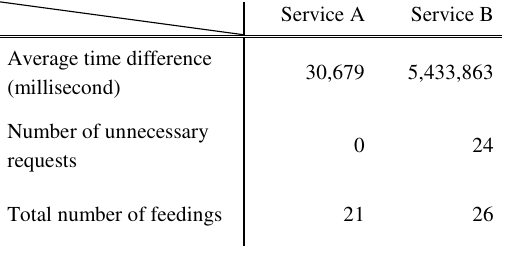
Table 1. Experimental